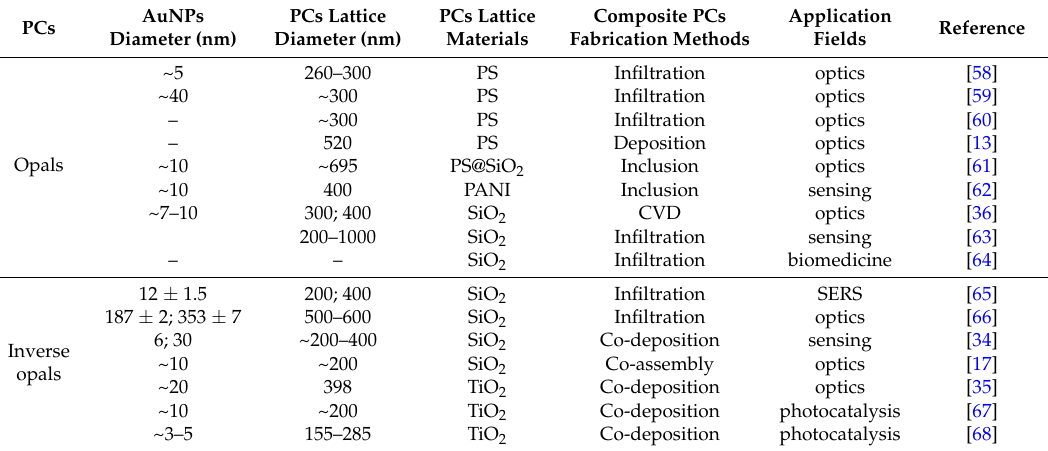
Table 1. Examples of composite PCs, useful in several application